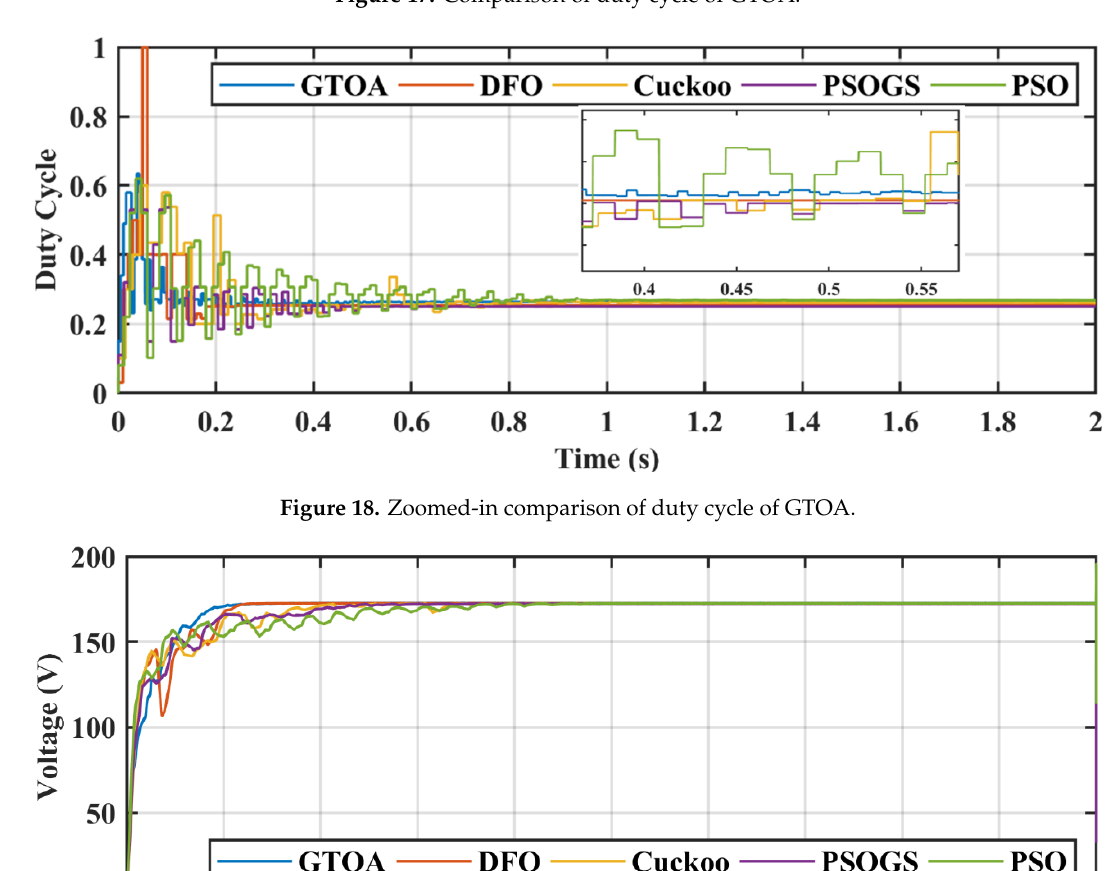
Figure 20. Comparison of current transients of GTOA. 4.3. Case 3: Partial Shading Case 3 dealt with a PS condition whose irradiance pattern was 720 W/m 2 , 850 W/m 2 , 1000 W/m 2 , and 550 W/m 2 . A power comparison is shown in Figure 21, and a zoomed-in comparison is presented in Figure 22. The duty cycle comparison of all the techniques in GTOA is shown in Figure 23, and the zoomed-in comparison of duty cycles in Figure 24. Power tracked by GTOA, DFO, CS, PSO, PSOGS was 799.2 W, 796.5 W, 786.6 W, 794.1 W, and 785 W, respectively. Their respective achieved efficiencies were 99.92%, 99.58%, 98.34%, 99.28%, and 98.14%. Tracking times of GTOA, DFO, CS, PSO, and PSOGS were 0.148 s, 0.205 s, 0.45 s, 0.3 s, and 0.39 s, with settling times of 0.25 s, 0.26 s, 1.2 s, 0.57 s, and 0.6 s, respectively. Voltage and current transient comparisons are shown in Figures 25 and 26.